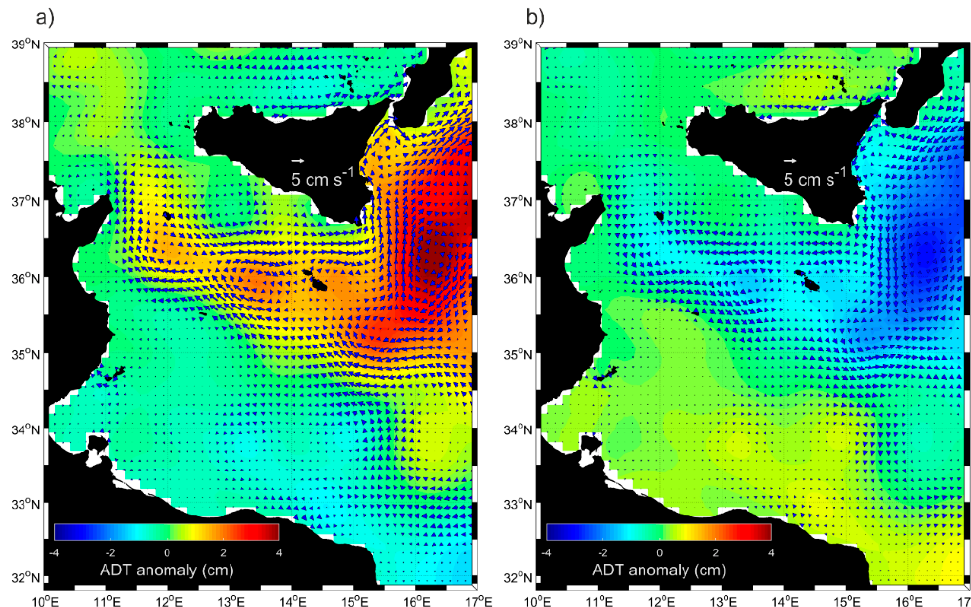
Figure 5. Mean maps of absolute geostrophic velocity anomalies (vectors) superimposed to the absolute dynamic topography anomalies (colours) during ( a ) anticyclonic (1993–1996,